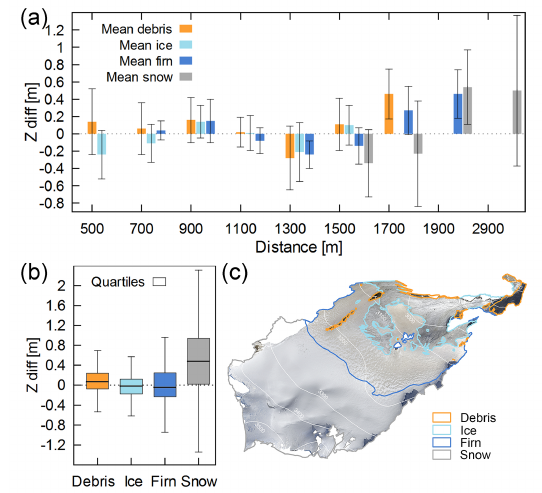
Figure 11. Elevation difference between the 2014 SfM–MVS and ALS-based DEMs calculated for different substrata. The figure shows (a) the mean and standard deviation of z difference for four substrata (debris, ice, firn and snow) grouped by distance from camera position and (b) the box plot of the z difference for four substrata. In the box–whisker plot, values which exceed 1.5 · IQR (interquartile range) were considered outliers. Panel (c) : the or- thophoto of the glacier on 27 September 2014 and map of